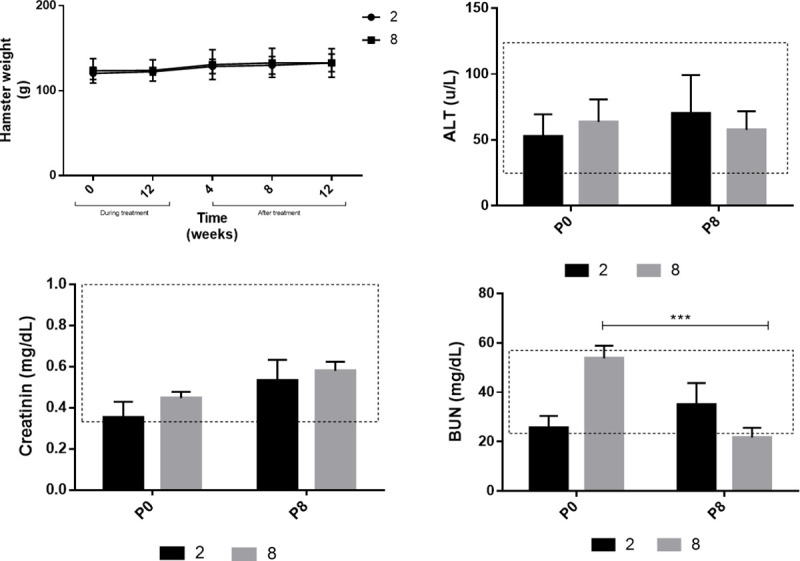
LW (g) and serum ALT, creatinine, and BUN levels pre and posttreatment with compounds 2 and 8.Data are presented as mean ± SD of (a) LW, (b) ALT, (c) creatinine, and (d) BUN in the serum of hamsters suffering from CL before (P0) and after (P8) treatment. Significant between-group differences (p < 0.05). The dotted area represents the reference values for each parameter. LW, live weight; ALT, alanine aminotransferase; BUN, blood urea nitrogen; SD, standard deviation; CL, cutaneous leishmaniasis.